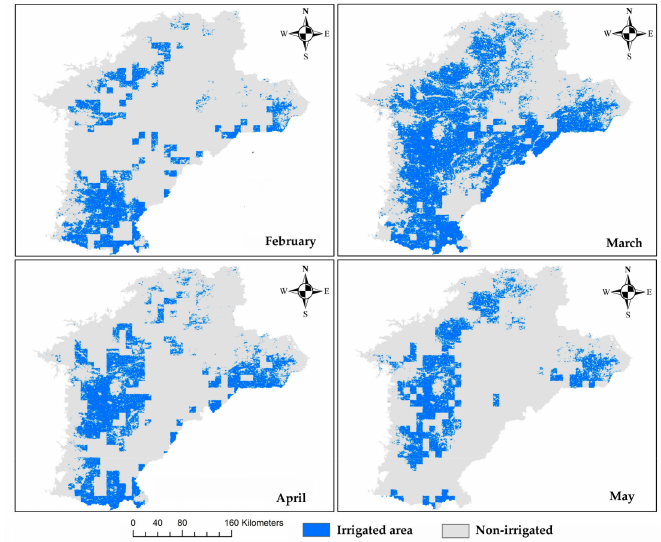
Figure 12. Spatial distribution of winter wheat irrigated